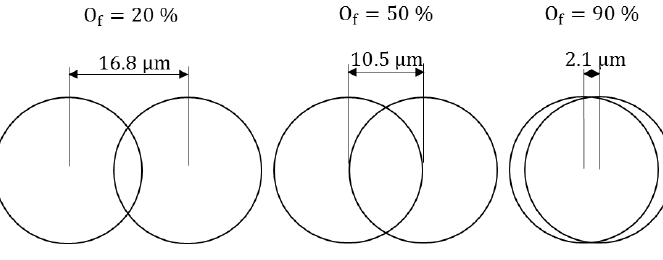
Figure 3. Schematic representation of pulse overlapping factor. Table 4. Process parameters for experimentation without gas blowing through the tube.